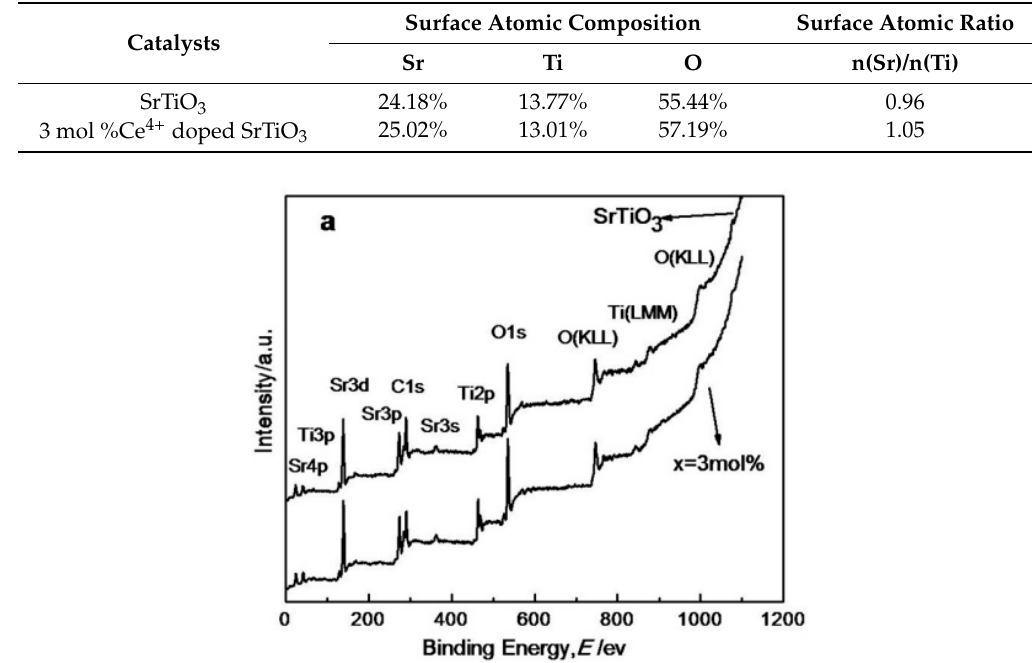
Figure 7. FTIR spectra of pure SrTiO 3 and 1 mol %, 2 mol %, 3 mol %, 4 mol % Ce 4+ doped SrTiO 3. Table 4. Surface atomic composition and atomic ratio of catalysts.